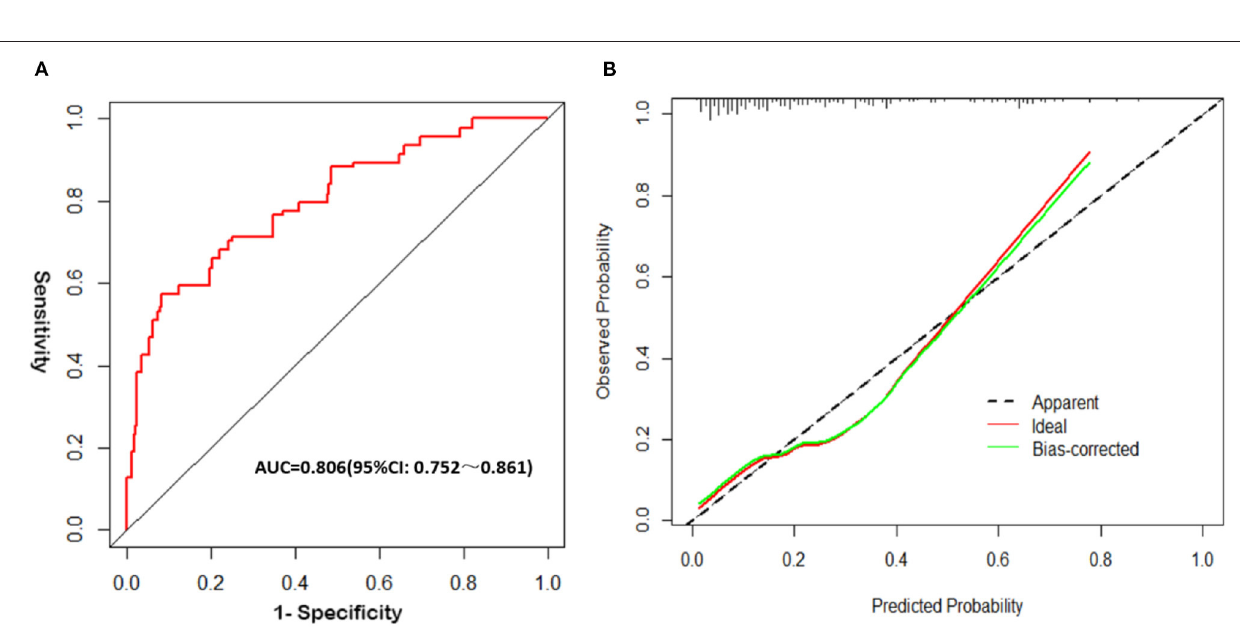
patients (12.8%) presented with poor FN function ( Figure 4A